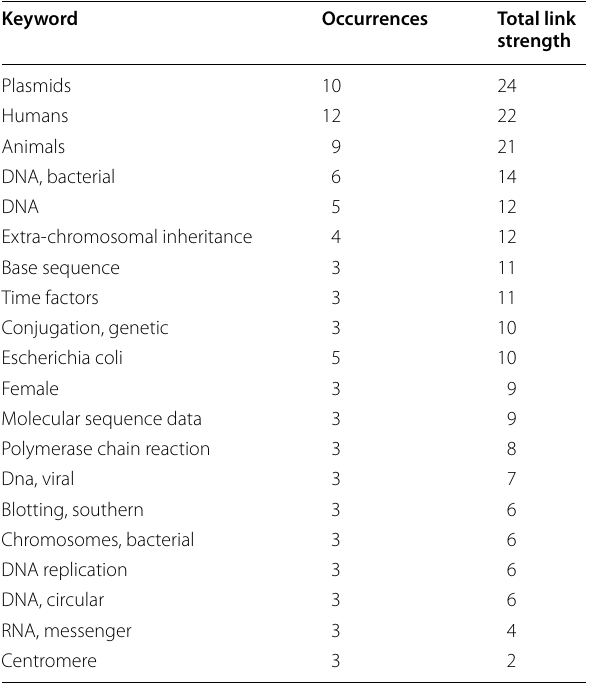
Table 3 Statistical distribution of occurrences, total link strength of all the keywords co-occurrence